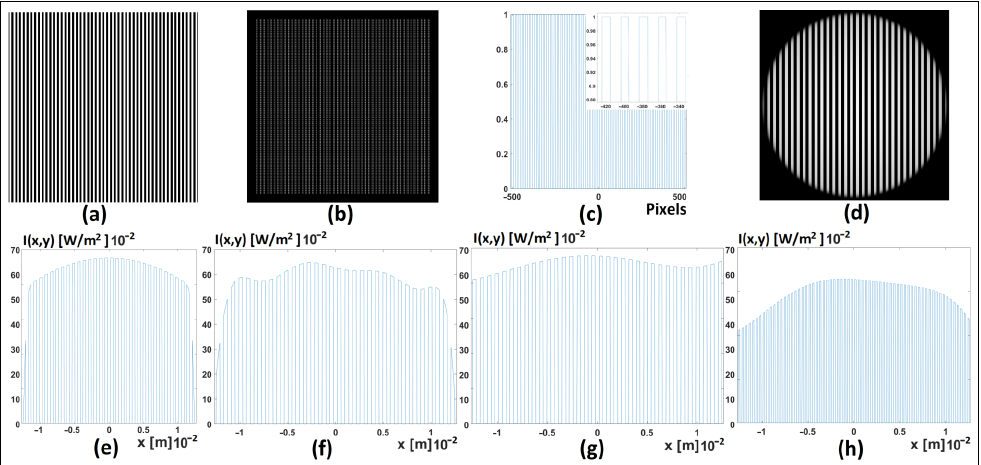
Figure 5. In ( a ) 50-fringes per inch SGR. In ( b ), the pattern in ( a ) is observed through the LCD, simulating the screen and the LCSLM width. In ( c ), we show the profile in ( d ). In ( b ), the 512 × 512- pixels LCD for illustrative purposes. In ( d ), we show the simulation of Figure 4a, considering the L1 pupil. In ( e ), the ideal profile of ( d ), whereas in ( f ), the simulations of the aberrations and deformations in the experimental intensity in Figure 4a and we show the corresponding profile. In ( f , g , h ), we show the intensities profile of L1, L2 and L3 (respectively), considering the LCSLM simulating the